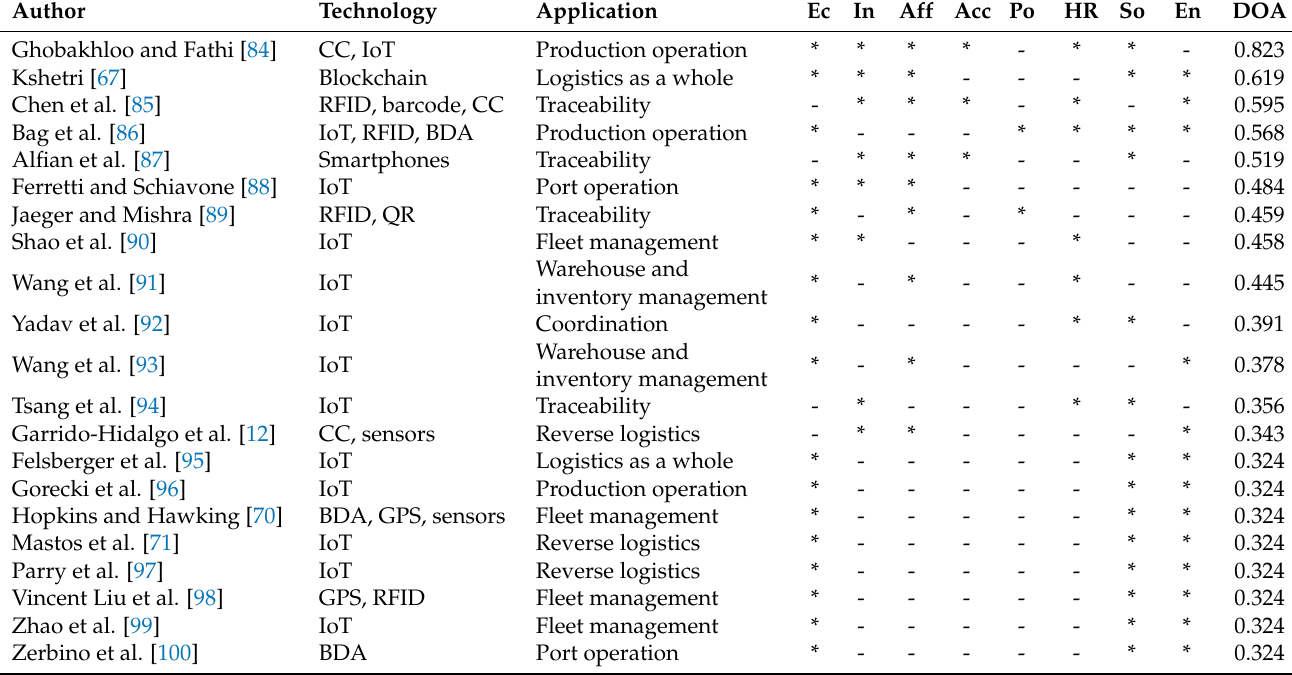
Table 7. Case studies focusing on adoption of digital